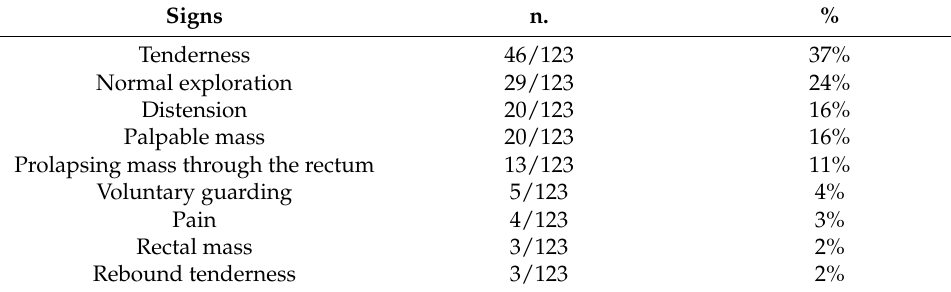
Table 2. Summary of the most common findings at physical